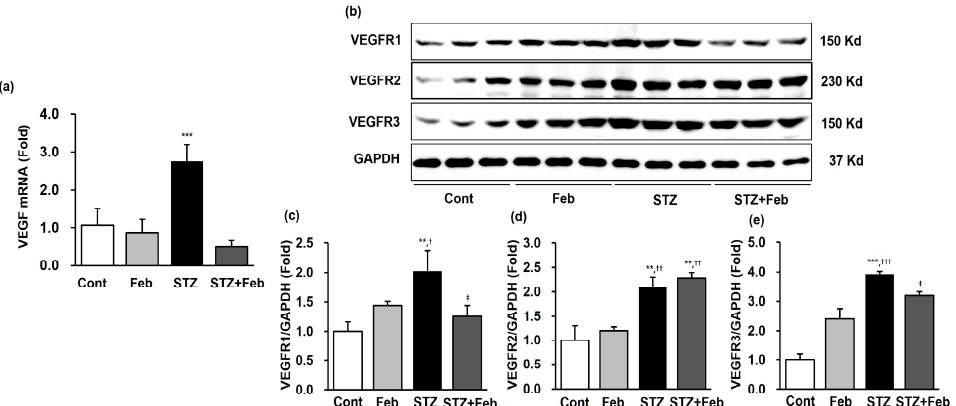
Figure 3. The expression of VEGF mRNA and representative images and quantitative analysis of VEGFR expressions in STZ-induced diabetic mice with or without febuxostat treatment. ( a ) The renal expression levels of VEGF mRNA, *** p < 0.001 vs. other groups. ( b ) Representative immunoblots for VEGFR1, VEGFR2, and VEGFR3 expression. ( c ) Quantitative analyses for VEGFR1/GAPDH. ( d ) Quantitative analyses for VEGFR2/GAPDH. ( e ) Quantitative analyses for VEGFR3/GAPDH, ** p < 0.01 and *** p < 0.001 vs. Cont, † p < 0.05, †† p < 0.01 and ††† p < 0.001 vs. Feb, and ‡ p < 0.05 vs. STZ